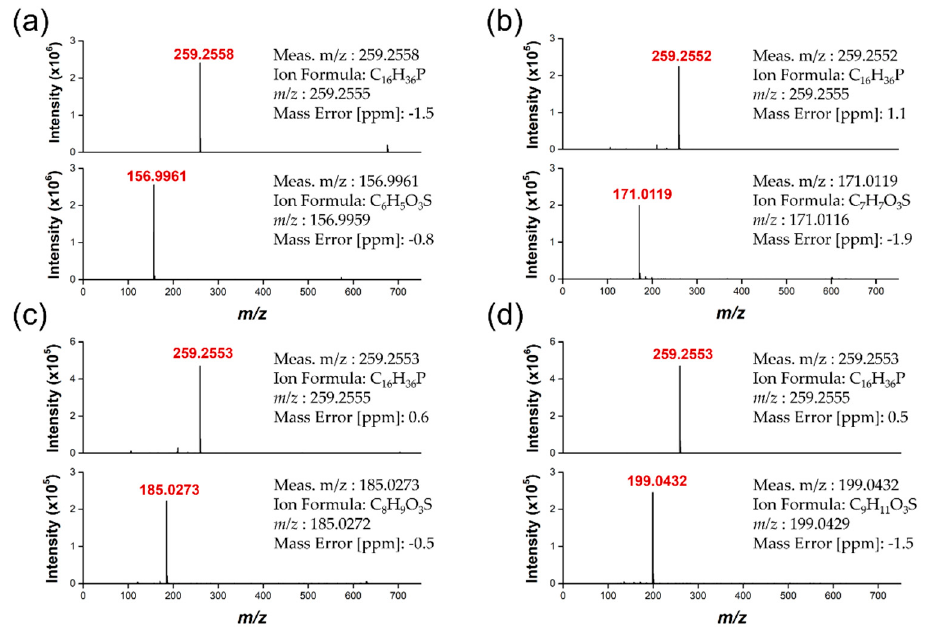
Figure 4. High − resolution mass spectrometer (HRMS) spectra of ( a ) [TBP][BS], ( b ) [TBP][MBS], ( c ) [TBP][DMBS], and ( d ) [TBP][TMBS].